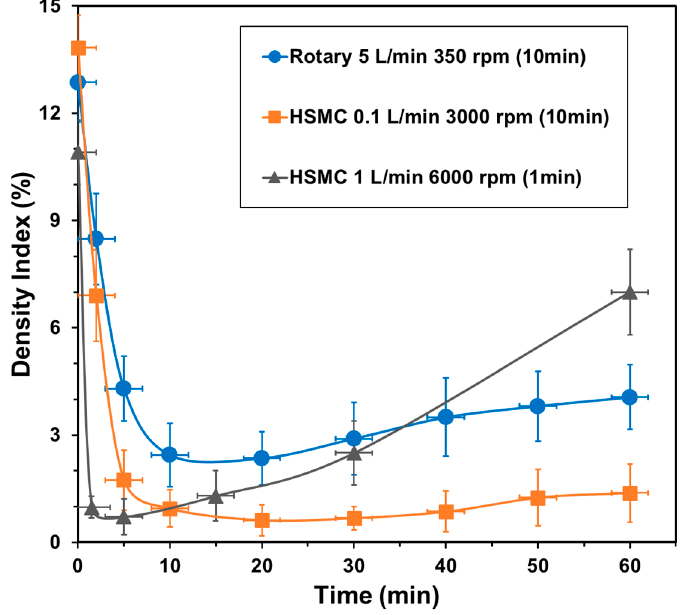
Figure 5. Comparison by Density Index evaluation of the HSMC degassing performance with conventional rotary degassing. Data points replotted from results in previous studies [24,32].